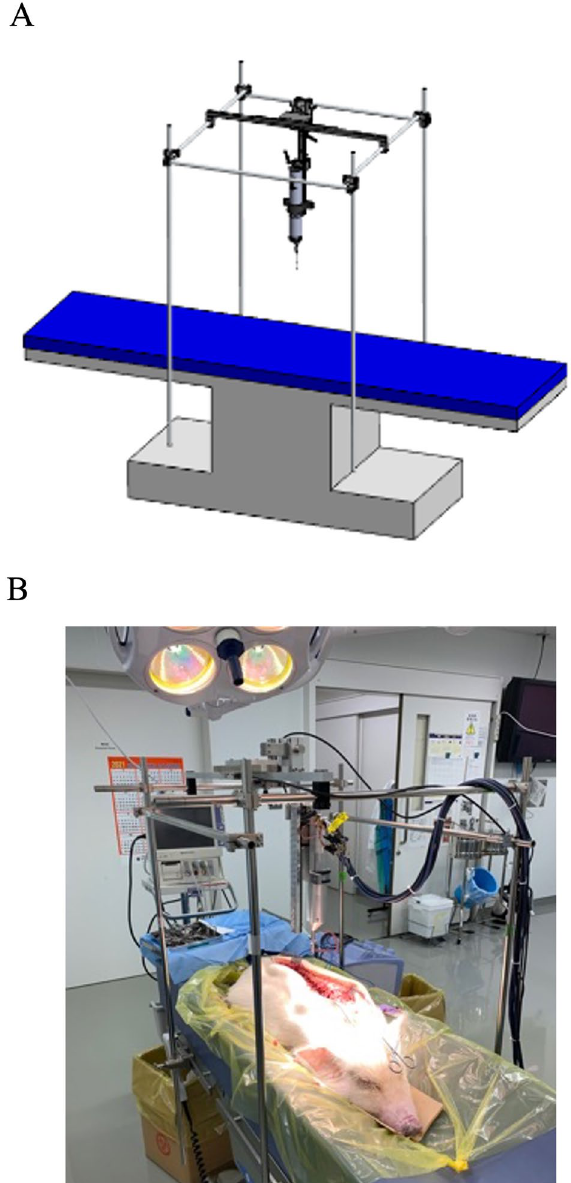
Figure 3. Schematic view of a custom-made surgical table for the animal experiments. ( A ) The custom-made surgical drill was placed directly above the surgical table via a post. ( B ) Intraoperative view of the animal